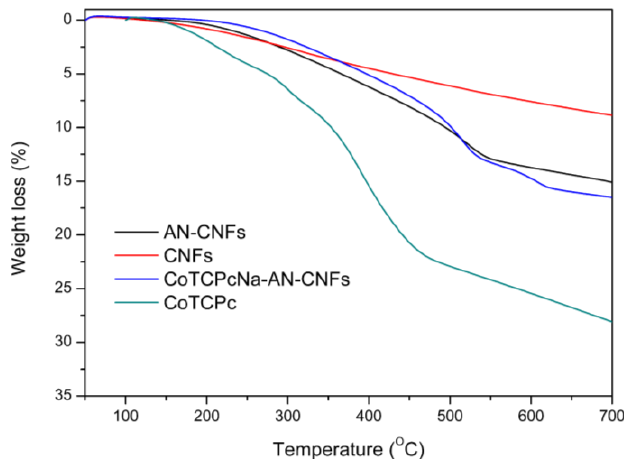
Figure 3. Dynamic thermogravimetric analytical curves of CNFs, AN-CNFs, CoTCPcNa-AN-CNFs and CoTCPc.